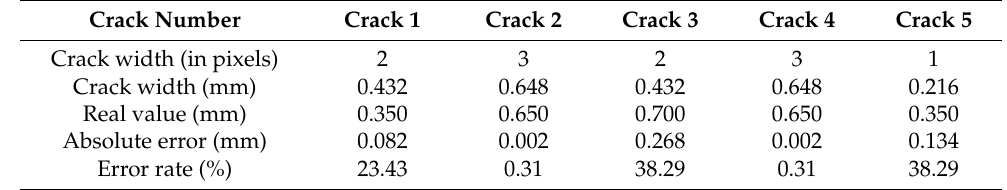
Table 7. Canny planar marking measurements (spatial resolution of one pixel: 0.216 mm).